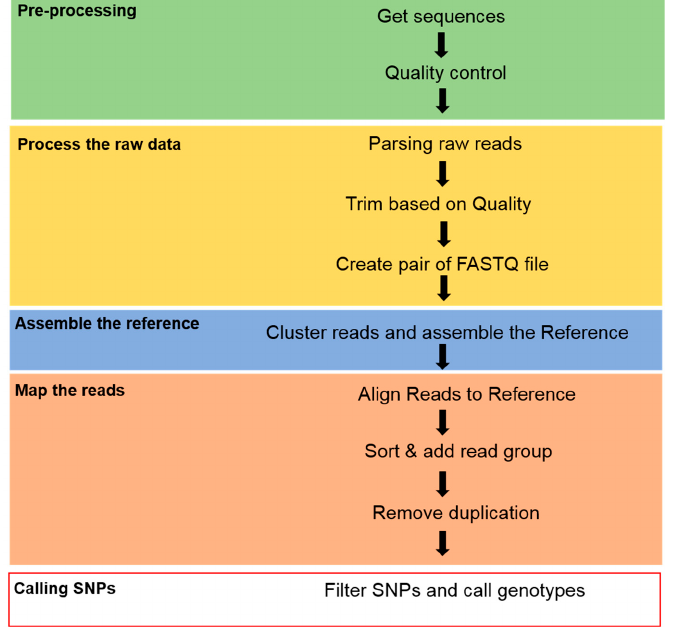
Figure 1. A pipeline for calling single nucleotide polymorphisms (SNPs) from genotype-by-sequencing (GBS) data.